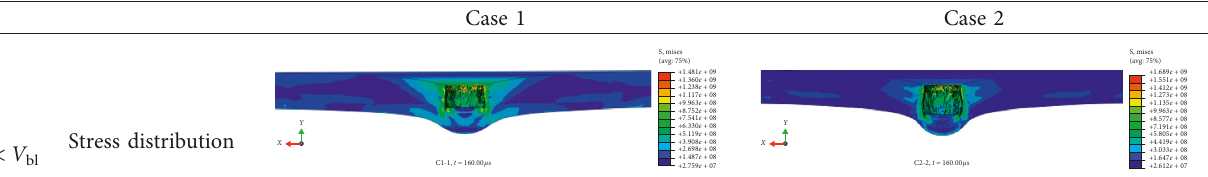
Table 9: Comparison of numerical simulation results in different